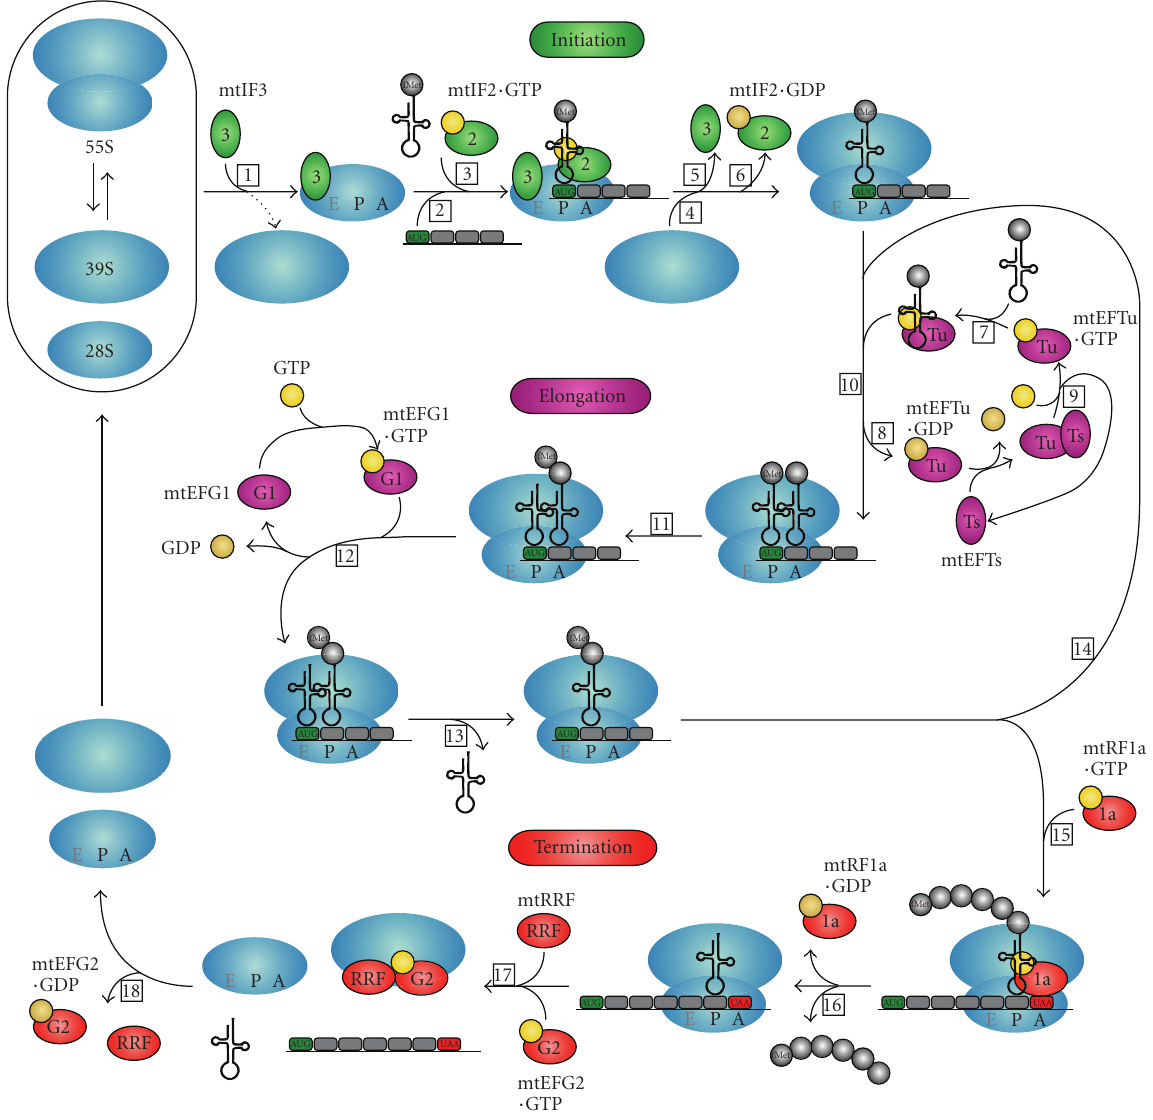
Figure 2: Diagram of human mitochondrial protein synthesis. The three phases of mitochondrial translation—initiation, elongation and termination—and all translation factors involved are represented in this figure. See Section 3.2 in the text for a detailed description of all steps (numbered in boxes) of the mitochondrial translation process. Initiation, elongation and termination factors are represented by green, purple and red ovals, respectively. GTP and GDP are shown in yellow and beige circles,